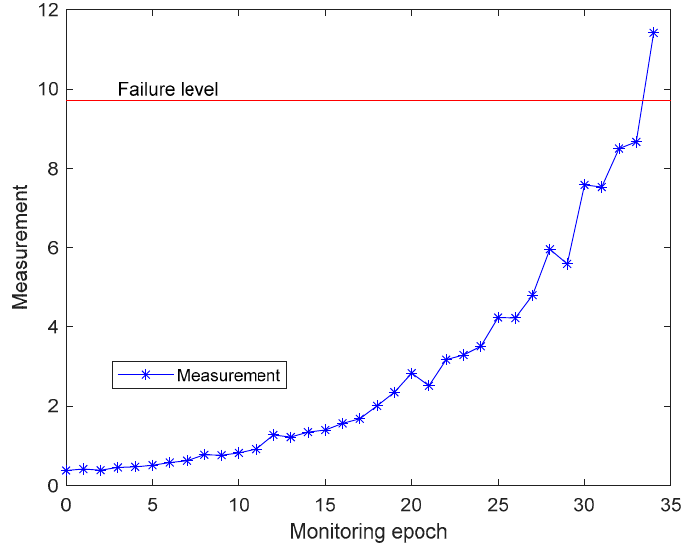
Figure 4. Measurements of an illustrated component.